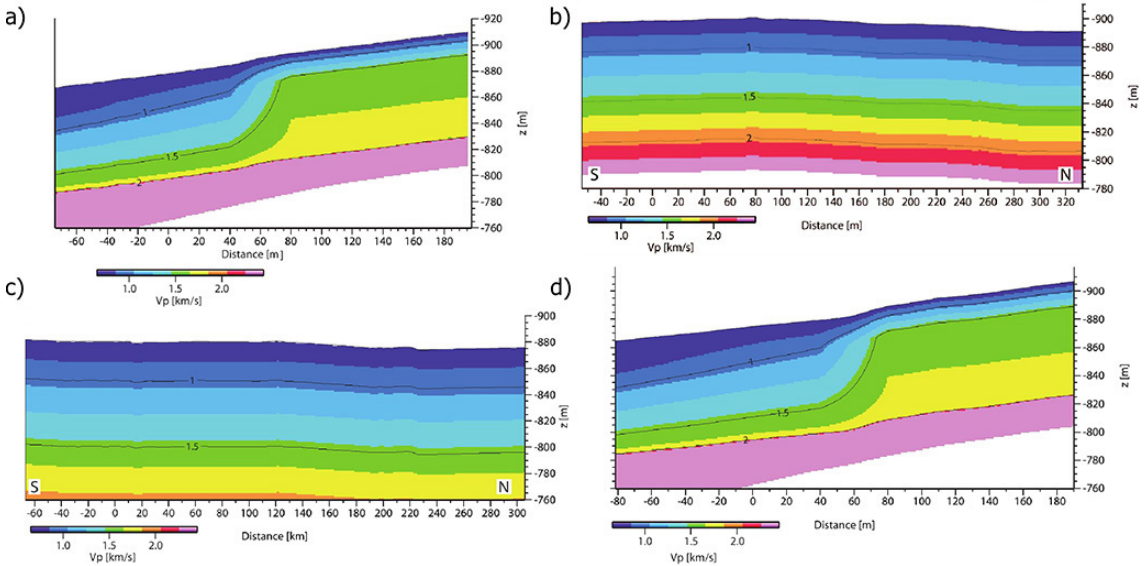
Figure A1. Initial velocity models for profiles (a) P1, (b) P2, (c) P3 and (d) P4.